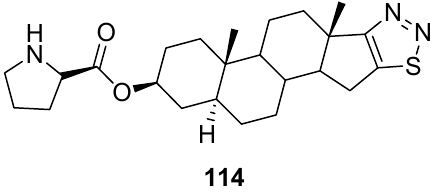
Figure 16. 1,2,3-Thiadiazole dehydroepiandrosterone derivative 114 as new antitumor